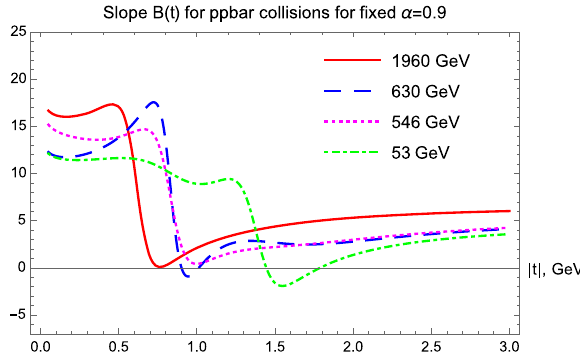
Fig. 11 Slope parameter B ( t ) for elastic pp collisions. The diffractive minimum followed by a diffractive maximum is present in each case, as evidenced by B ( t ) crossing the B ( t ) = 0 line twice in each case